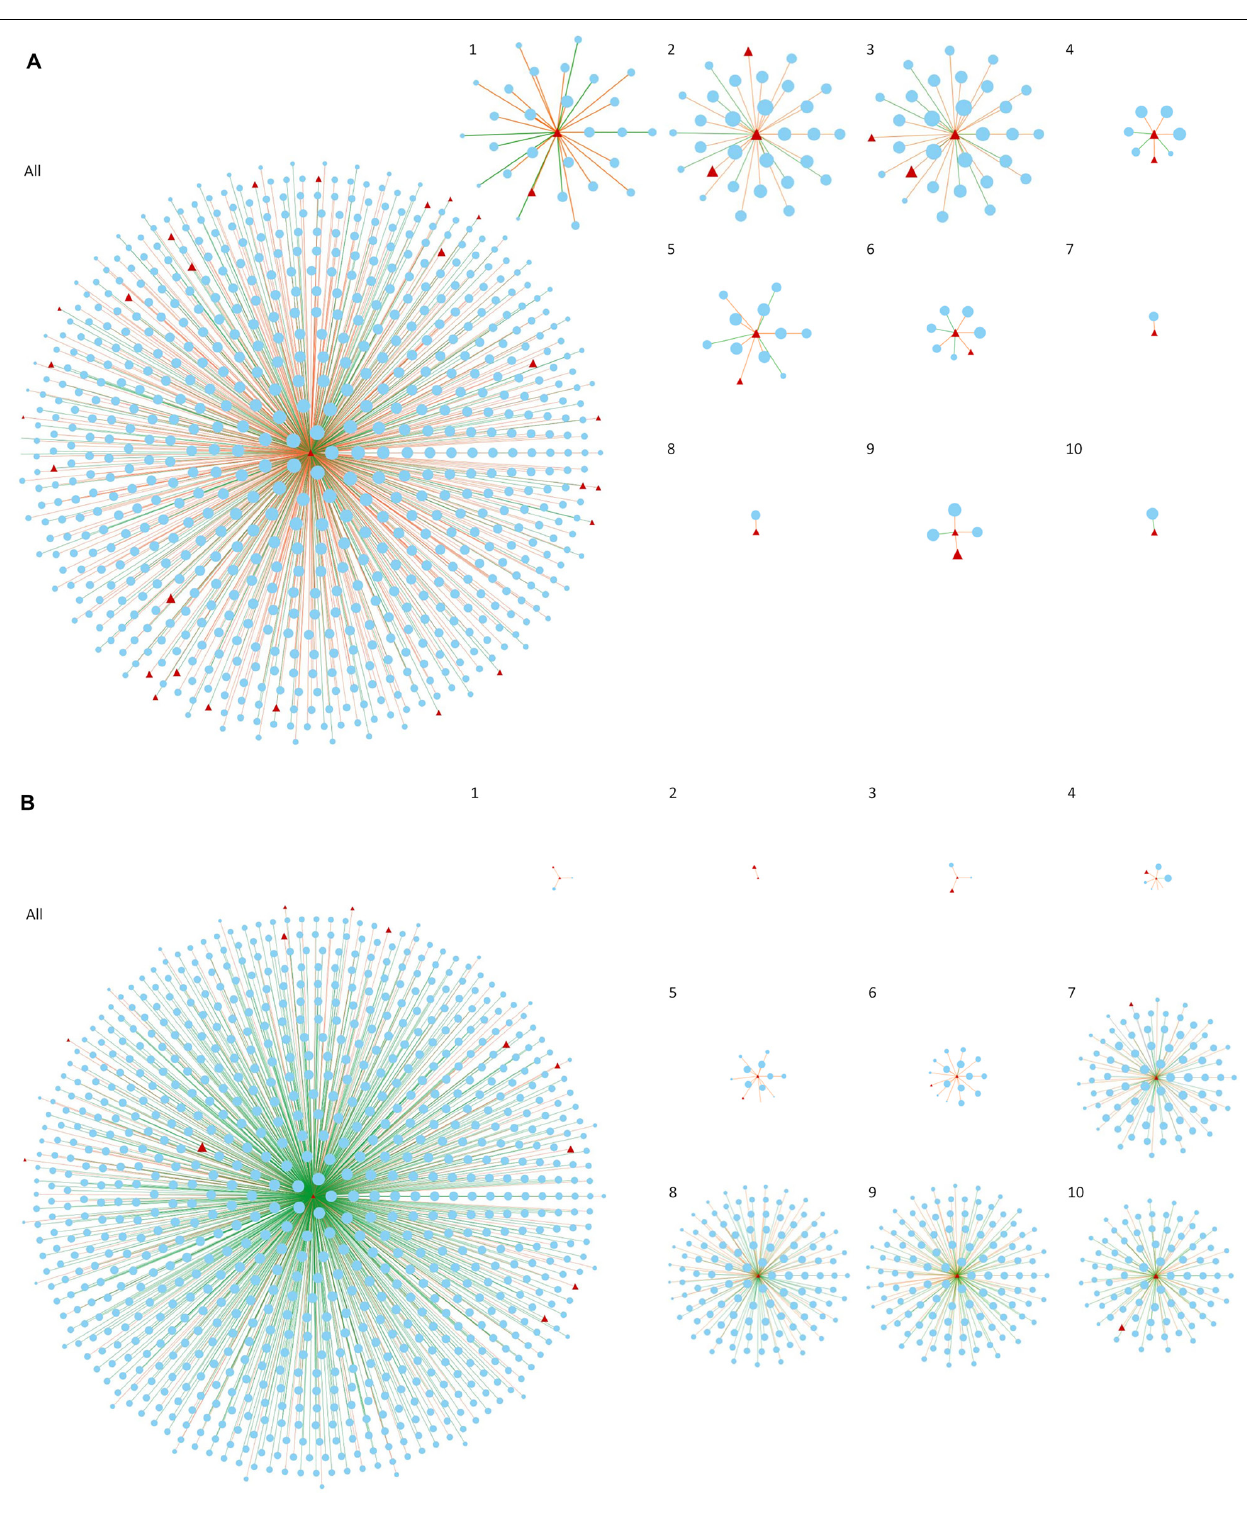
Frontiers in Genetics |